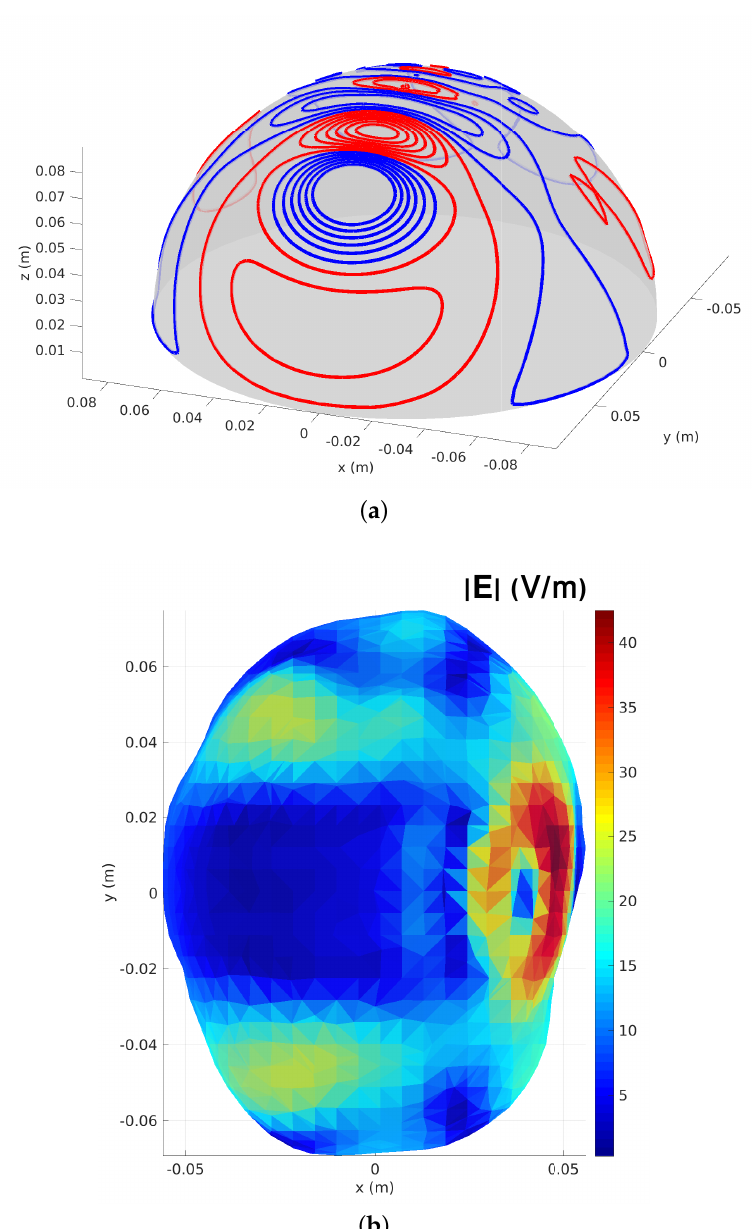
Figure A2. ( a ) Wirepaths with 18 turns of the TMS coil solution (red wires indicate reversed current flow with respect to blue). ( b ) E-field modulus induced at the surface of the brain by the designed TMS